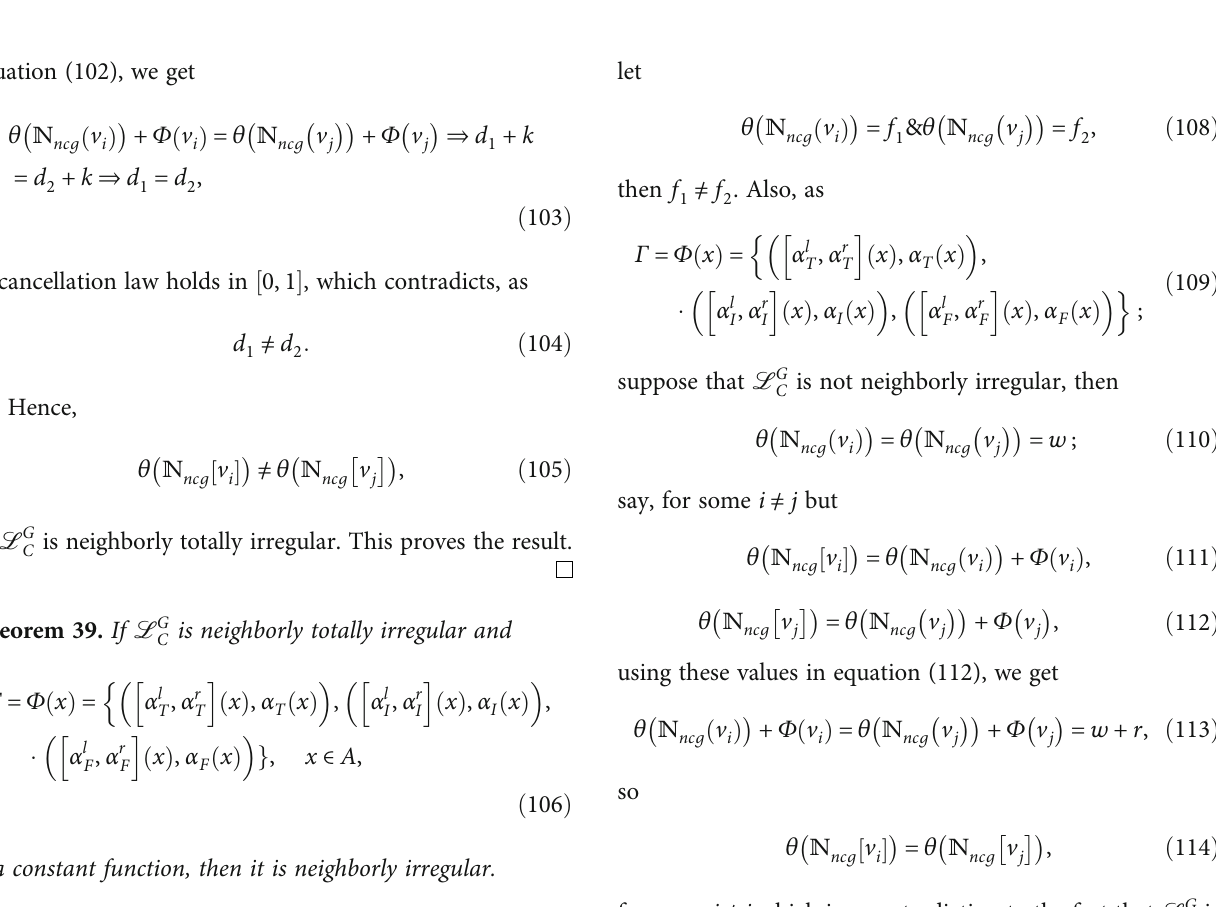
Figure 10: Represents a complete neutrosophic cubic graph, but not neighborly